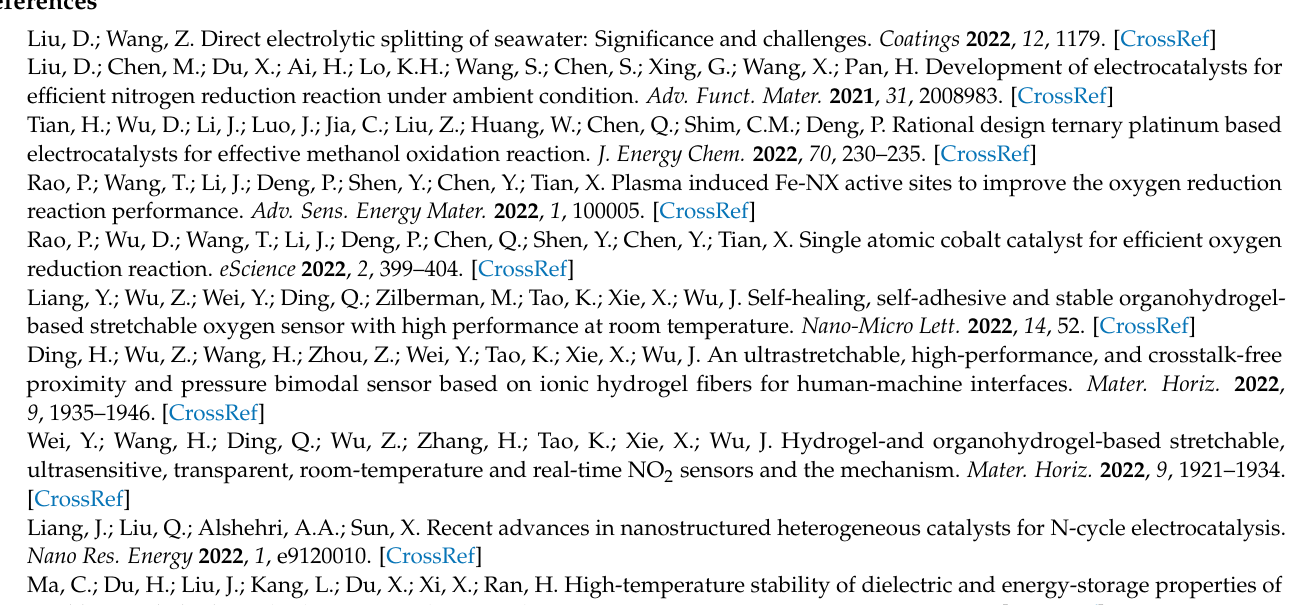
Si-CNTs composite material.; Figure S2: Thermogravimetric curves of PS and SiO2@PS in an air atmosphere.; Figure S3:XRD patterns of hollow SiO 2 .; Figure S4: A model of the silicon crystal structure.; Figure S5: SEM image of CNTs.; Figure S6: CV of the 50 nm hollow Si for the first three cycles at a scan rate of 0.1 mV/s.; Figure S7: CV curves of the first three cycles of the Si-CNTs at a scan rate of 0.1mV/s.; Figure S8: Columbic efficiency of these electrodes at 0.2A g − 1 .; Figure S9: Cycling performance for solid nano-silicon spheres.; Table S1: Comparison of cycle performance of different silicon-based anodes. References [59–62] are cited in the Supplementary